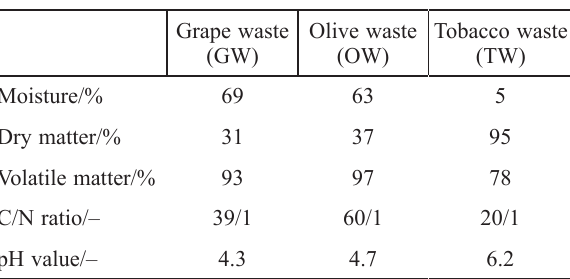
Table 1 – Initial characteristics of GW, OW and TW